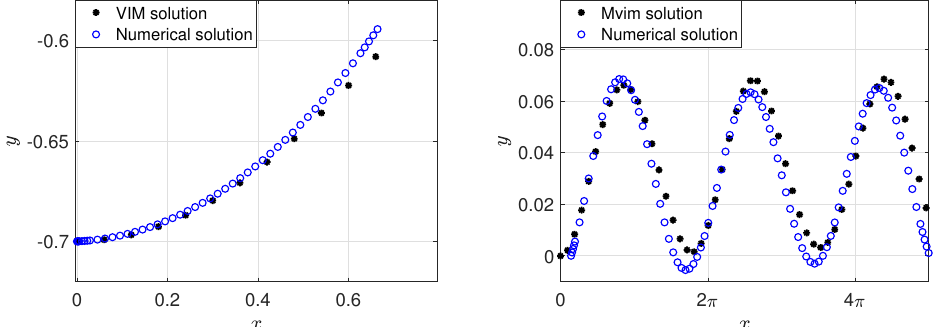
Figure 3. Numerical solution versus variational iteration method (VIM) solution: the left figure at ( α , h ) = (1, 1), and the right figure at ( α , h ) = (0.98, 0.1)